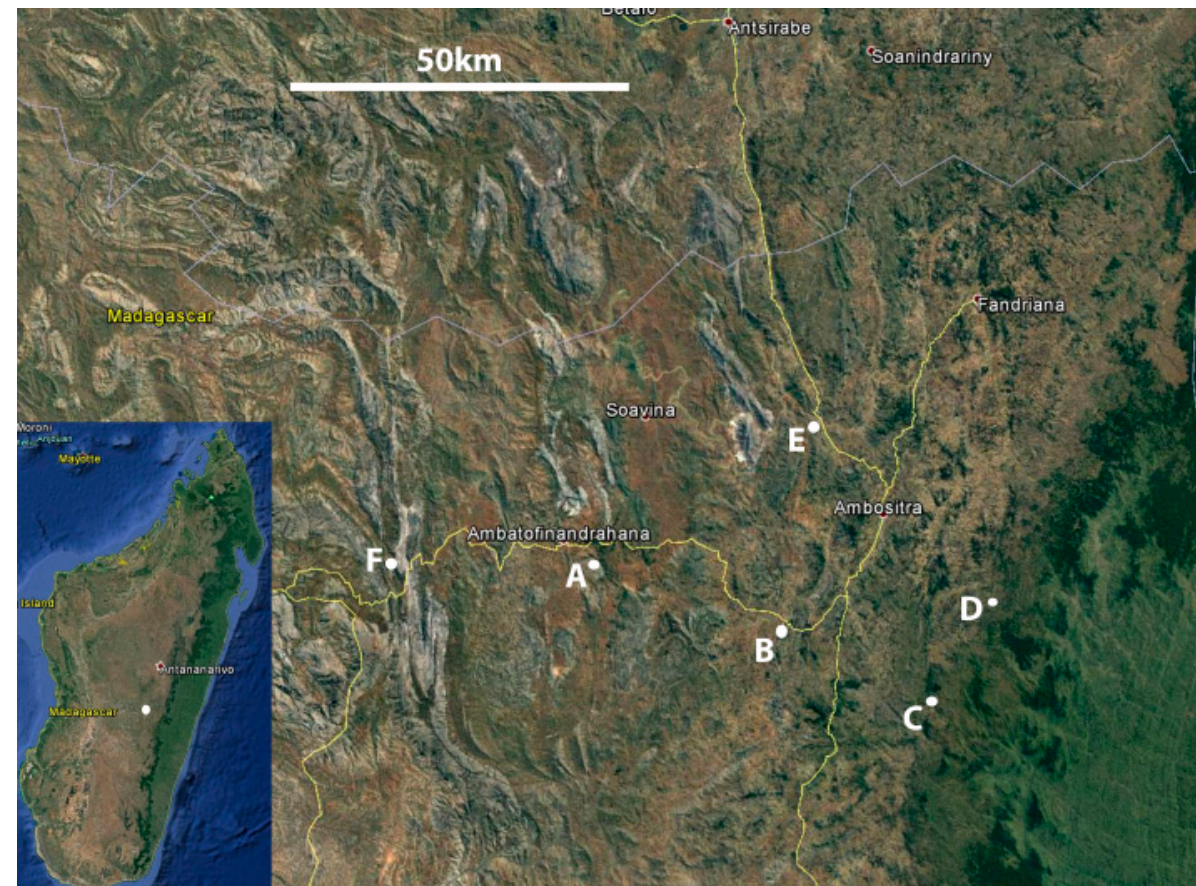
Figure 1. Location of study site in the Central Highlands of Madagascar (inset) and collection sites A–F (main). Scale bar= 50 km. Image courtesy of Google Maps.